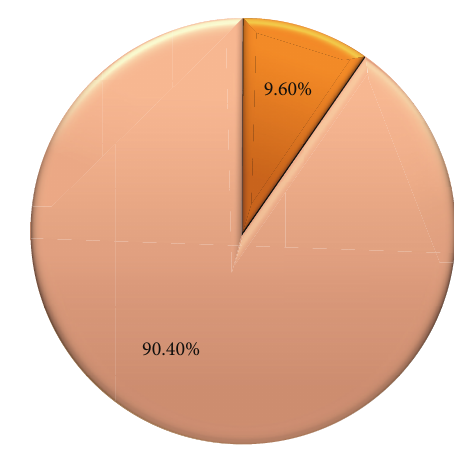
Figure 2: Prevalence of male involvement in birth preparedness practices at Chencha district, southern Ethiopia,